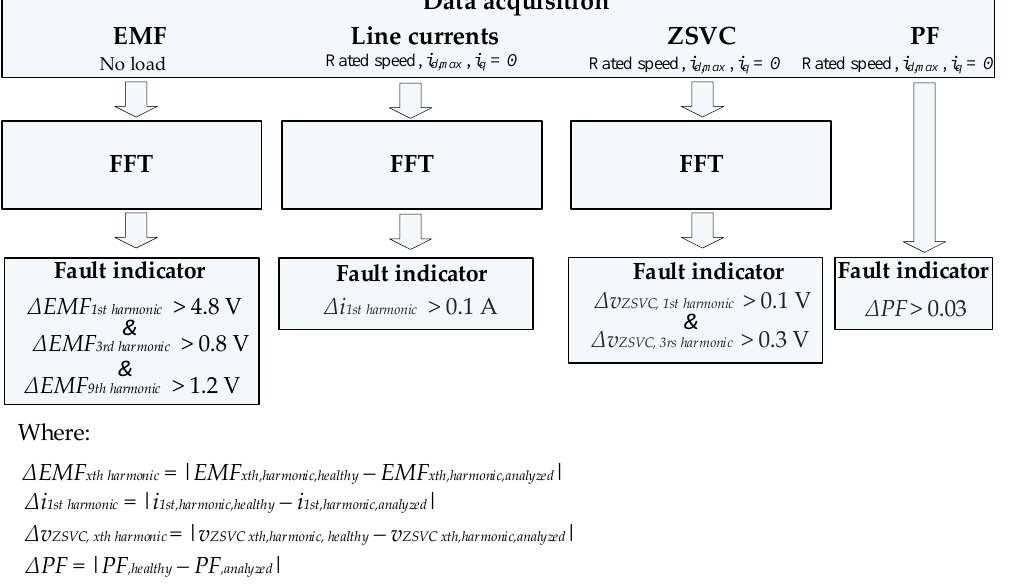
Figure 7. Proposed fault indicators and partial demagnetization diagnosis strategy.